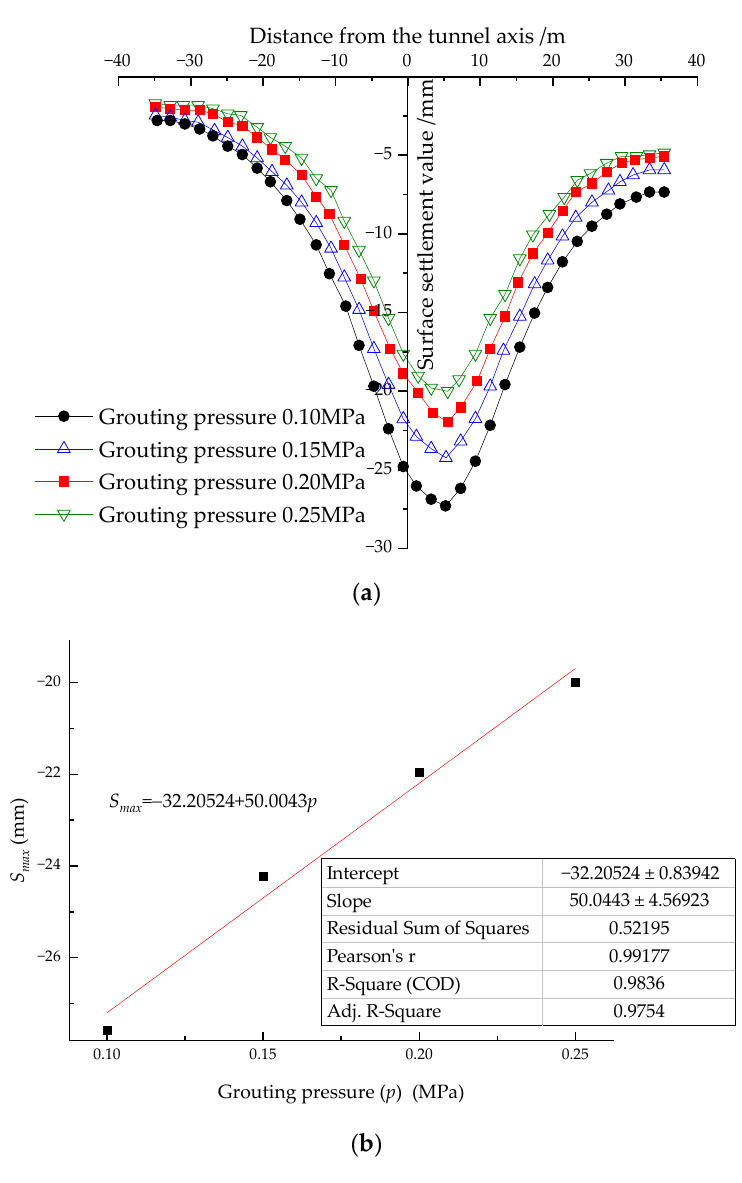
Figure 12. Surface settlement under various grouting pressures: ( a ) curves of surface settlement; ( b ) maximum surface settlement with various grouting pressures.